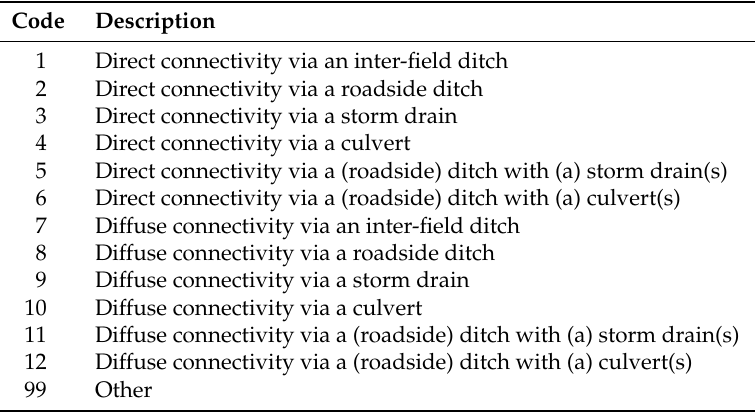
Table A5. Explanatory details for mapping units connected in an artificial way. Diffuse connectivity in this context means that an artificial connection is either diffusely present in a downstream mapping unit (see code 2 of Table A4) or that an artificial structure is not directly connected to a surface water (e.g., a ditch ending in a forest).